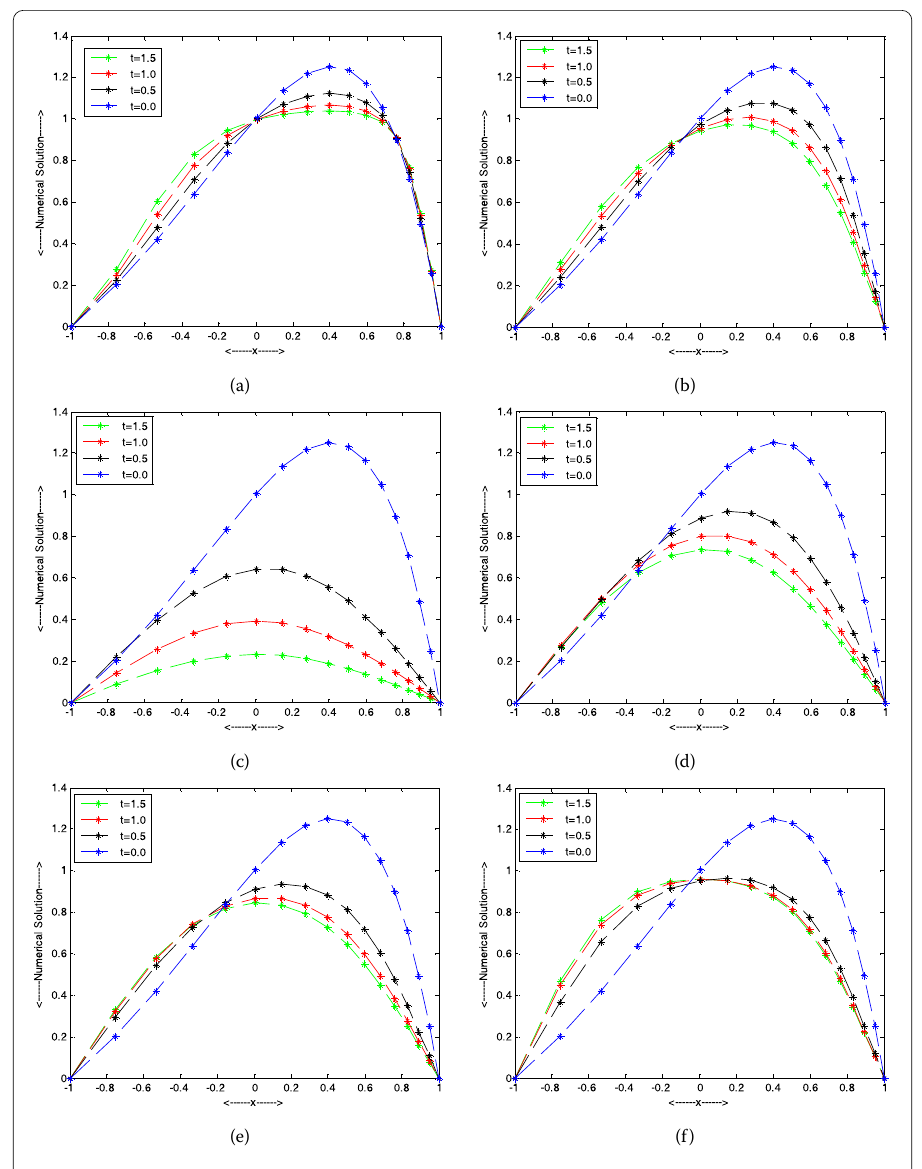
Figure 2 Example 3: Computed solutions for different time levels. (a) ε = 0.005, β = 1.0, (b) ε = 0.05, β = 1.0, (c) ε = 0.5, β = 1.0, (d) ε = 0.2, β = 1.5, (e) ε = 0.2, β = 2.5, (f) ε = 0.2, β =